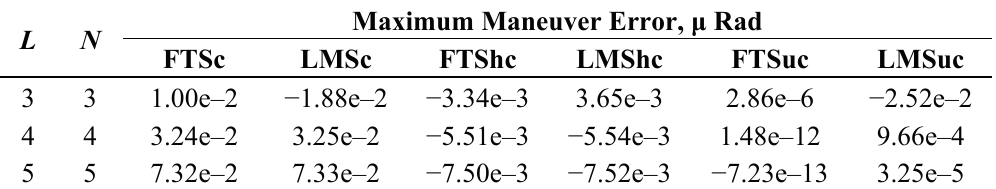
Old Table 17. Maximum maneuver error over 2 s maneuver.